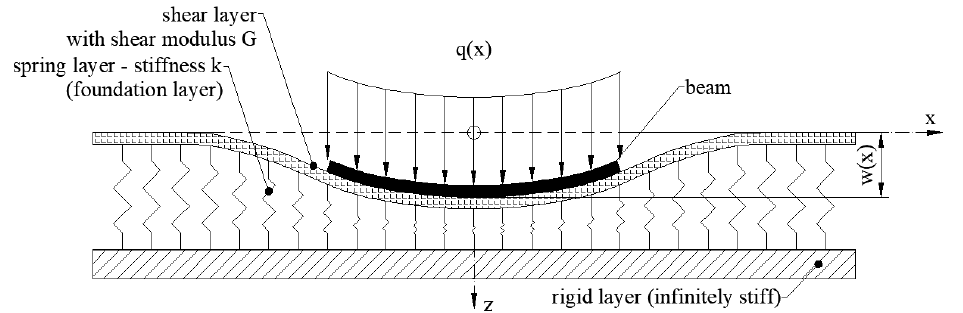
Figure 4. Beam on elastic foundation—Pasternak model.